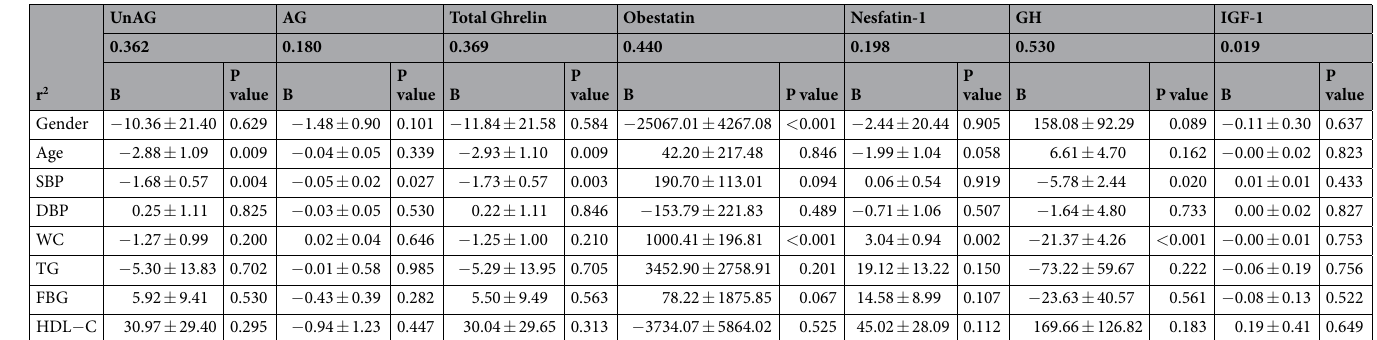
Table 3. Summary of multivariate linear regression of ghrelin gene products, nesfatin-1, GH and IGF-1 with age, gender and cardiometabolic risk factors. UnAG, unacylated ghrelin; AG, acylated ghrelin; SBP, systolic blood pressure; DBP, diastolic blood pressure; WC, waist circumference; TG, triglycerides; FBG, fasting blood glucose; HDL-C, high-density lipoprotein cholesterol; B: unstandardized coefficient. Data was analyzed by multivariate linear regression. Significance level was set at p <